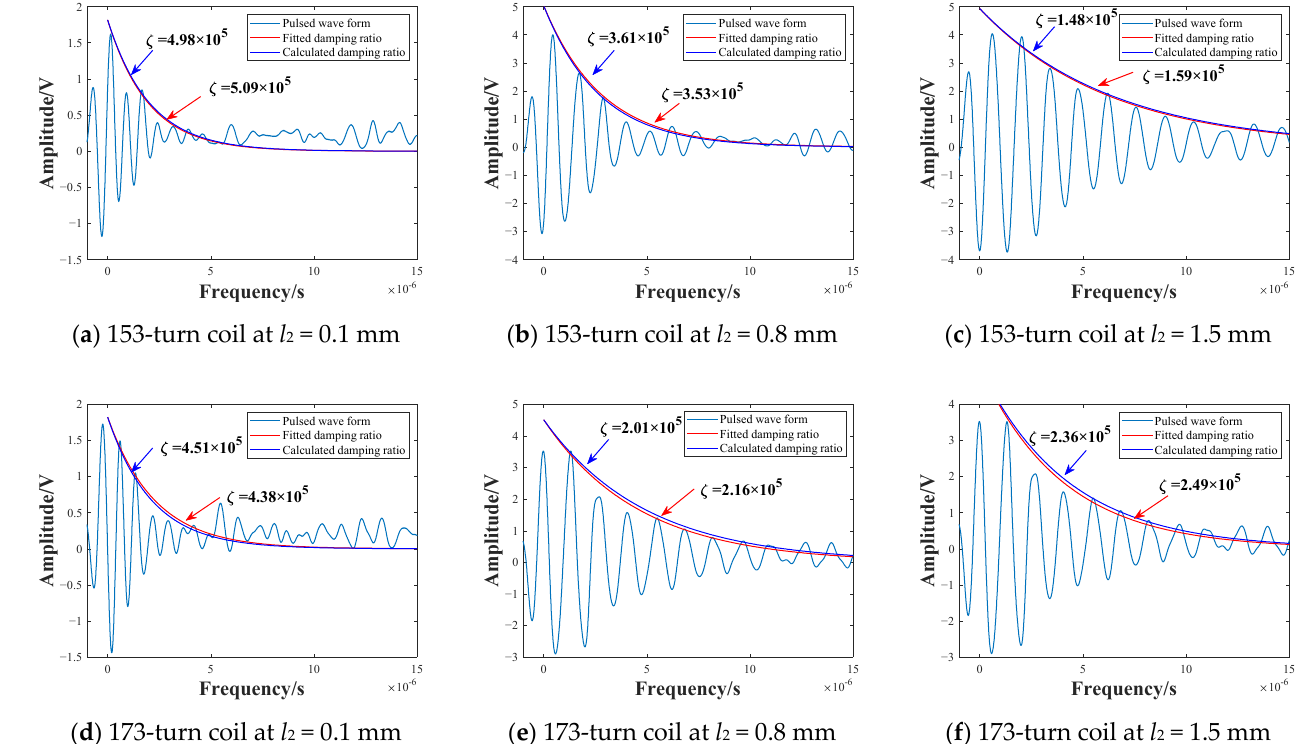
Figure 11. Fitting results of ( a ) 153-turn coil at l 2 = 0.1 mm ( b ) 153-turn coil at l 2 = 0.8 mm ( c ) 153-turn coil at l 2 = 1.5 mm ( d ) 173-turn coil at l 2 = 0.1 mm ( e ) 173-turn coil at l 2 = 0.8 mm ( f ) 173-turn coil at l 2 = 1.5 mm.